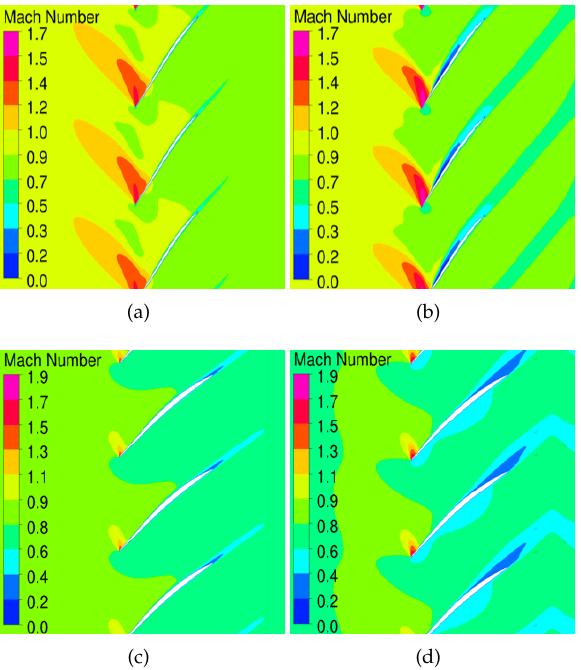
Figure 5. Comparison of relative Mach number contours. ( a ) OP1, 90% span. ( b ) OP3, 90% span.